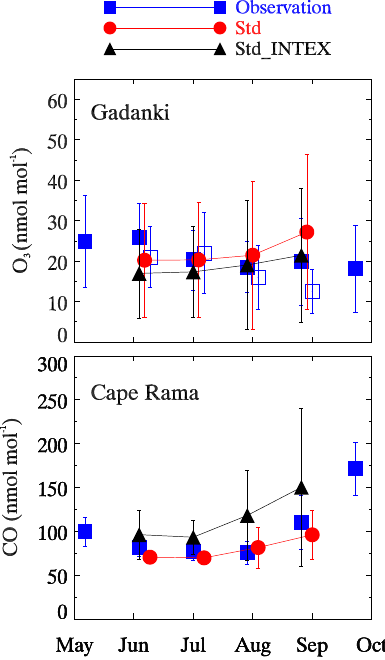
Figure 8. Comparison of WRF-Chem simulated surface ozone and CO with the ground-based measurements at Gadanki (79.2 ◦ E, 13.5 ◦ N; Naja and Lal, 2002) and Cape Rama (73.8 ◦ E, 15.1 ◦ N). Open blue symbols for Gadanki show observations from another study (Renuka et al., 2014). Comparison with Std_INTEX simula- tion is indicated in